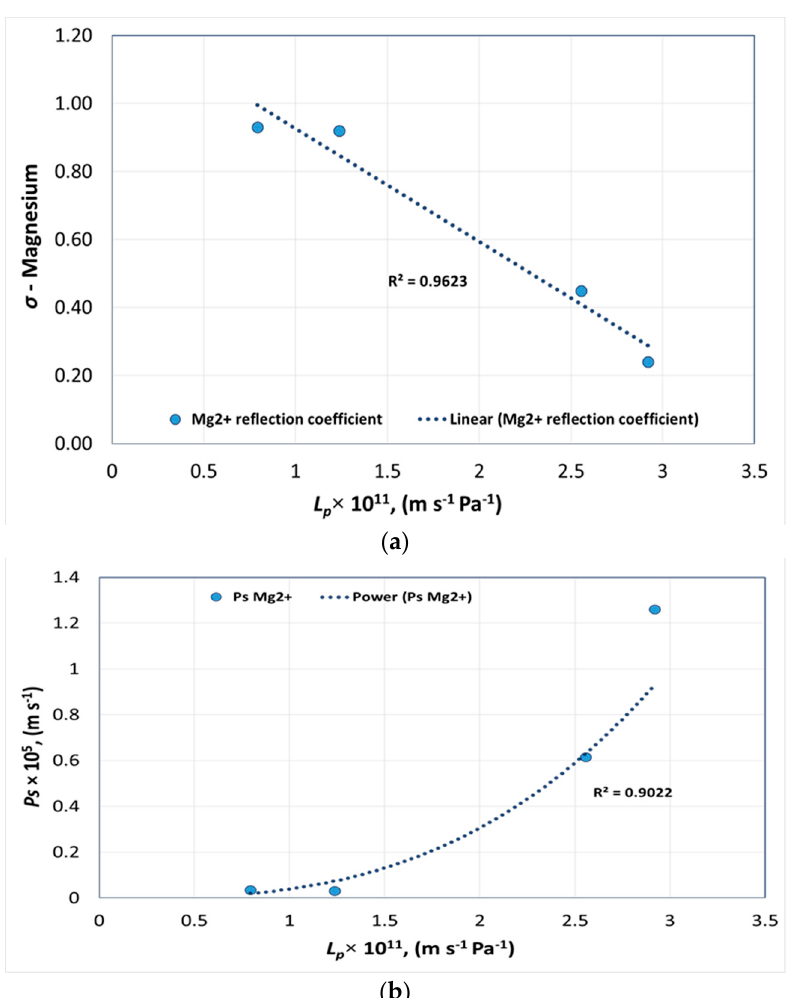
Figure 7. Pure water permeability versus ( a ) reflection coefficient and ( b ) solute permeability of magnesium.